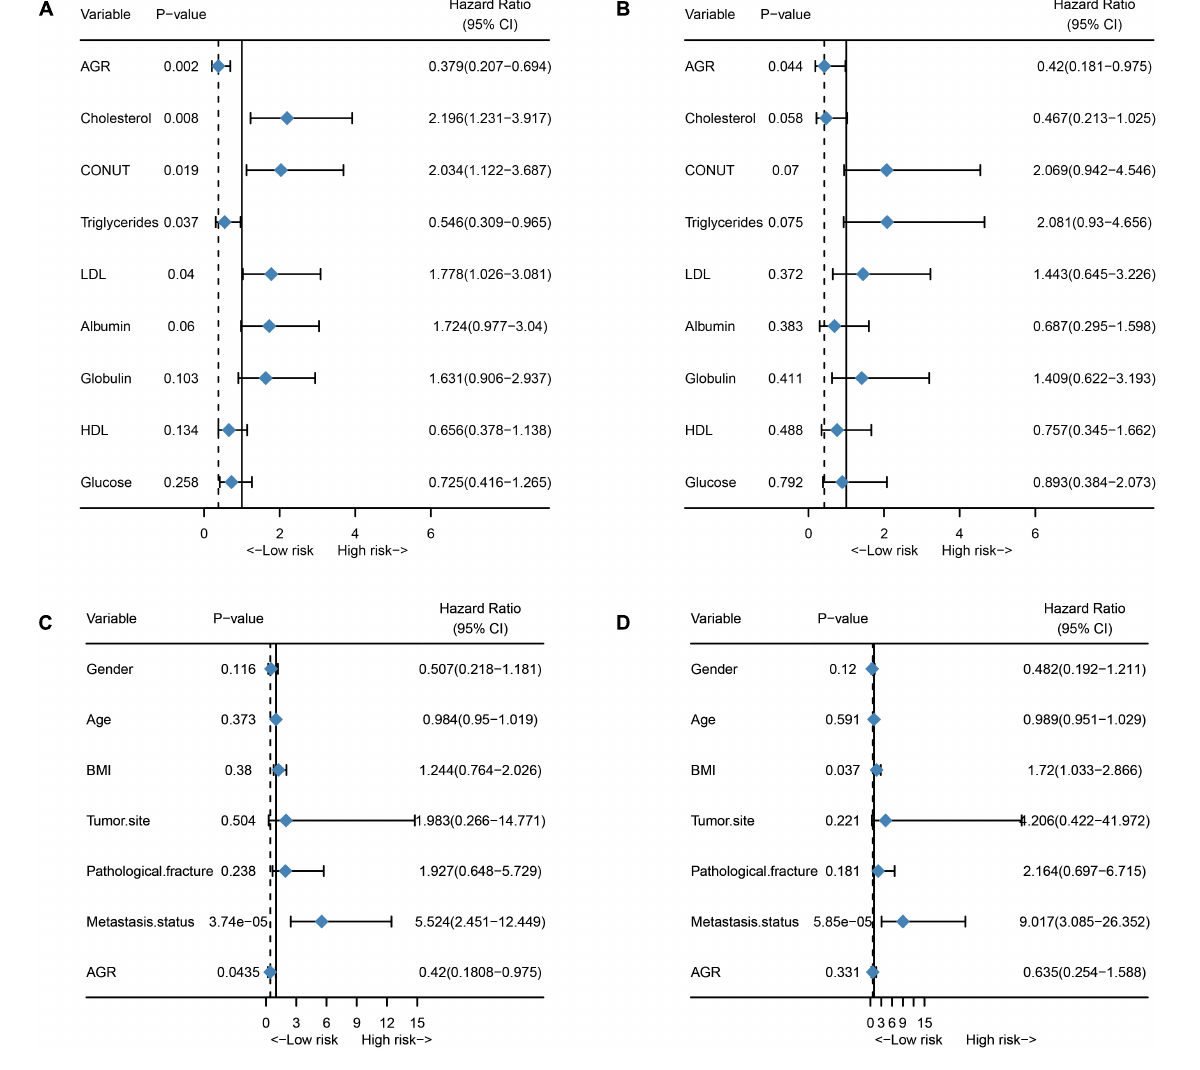
FIGURE 7 | Prognostic value of individual hematological markers and AGR in the training and validation sets. (A) Univariate cox regression analysis results of a single hematological marker in the training set; (B) Univariate cox regression analysis results of a single hematological marker in the validation set; (C) Univariate cox regression analysis of AGR in the validation set; (D) Multivariate cox regression analysis of AGR in the validation